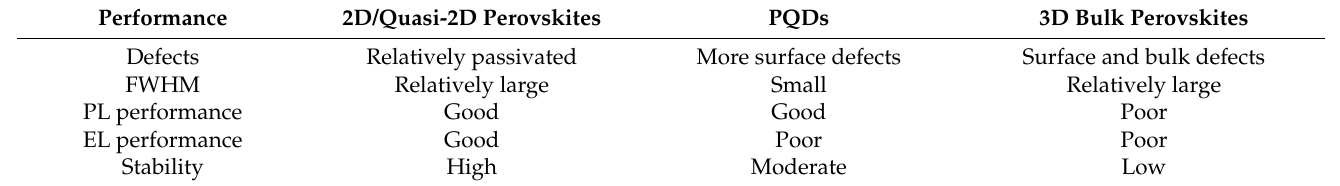
Table 2. Two strategies to achieve blue light-emitting perovskites and comparison in several aspects. Performance 2D/Quasi-2D Perovskites PQDs 3D Bulk Perovskites Defects Relatively passivated More surface defects Surface and bulk